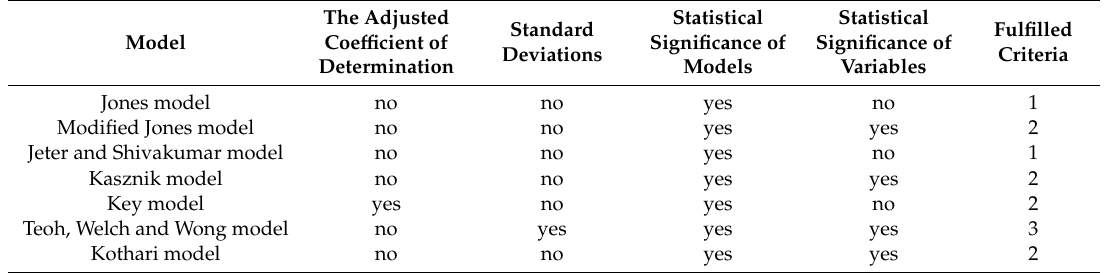
Table 9. The overview of fulfilled criteria of earnings management models in Slovak conditions.